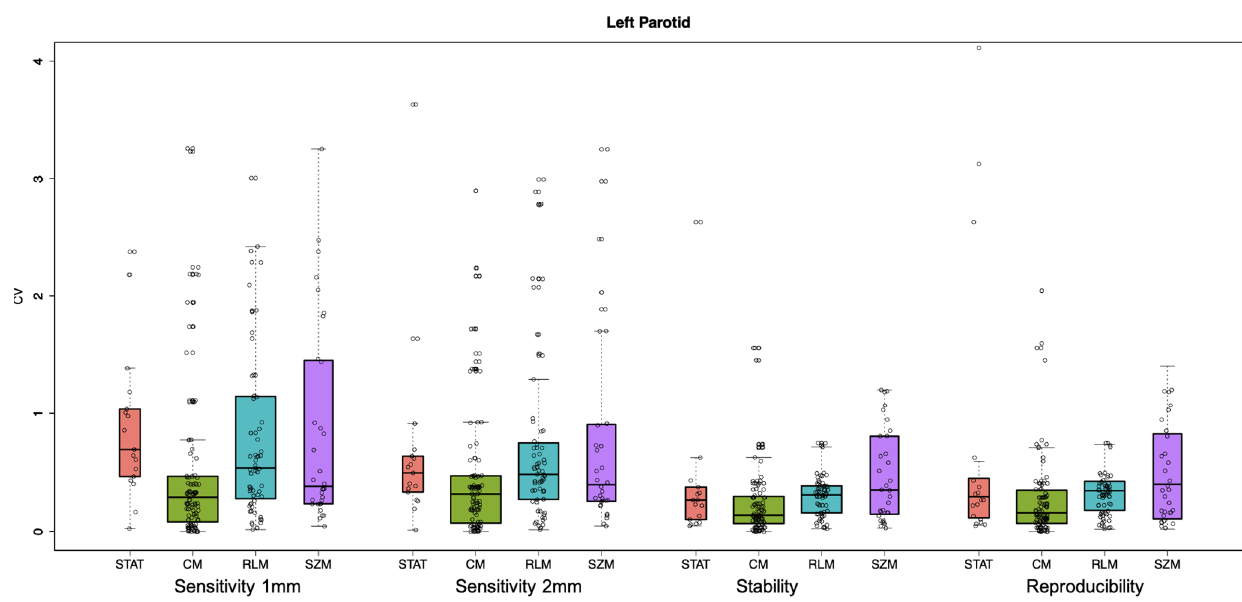
Cancers 2021 , 13 , x Figure 4. Box plots of the CV values for the sensitivity (1 mm and 2 mm), stability and reproducibility studies, grouped for the four different features’ families (STAT, CM, RLM and GSZ) for the left parotid.